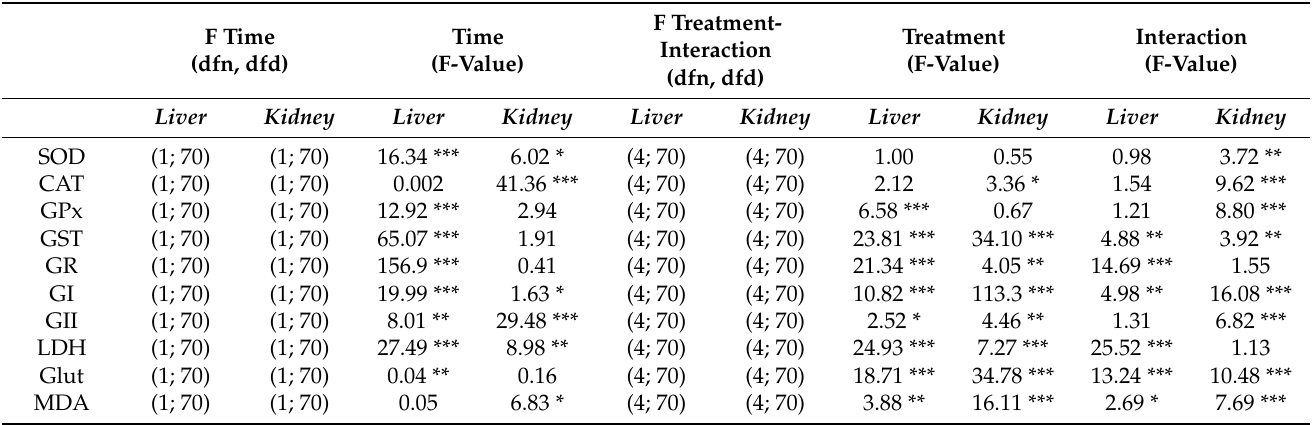
Table 4. Results of two-way ANOVA of time (15 and 30 days), treatment (F1-BEO substitution in fish diets) and interaction (time x treatment) on livers and kidneys of O. mykiss